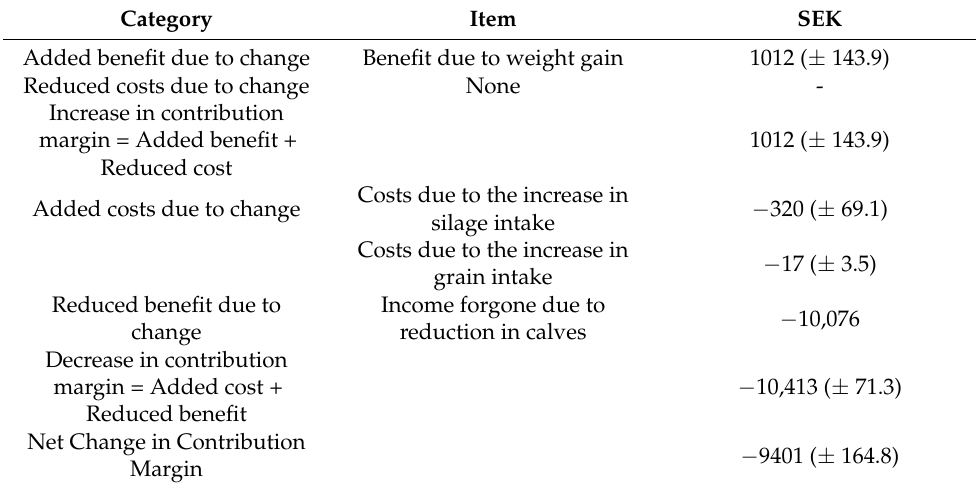
Table 3. Effects a of an increase in space allowance (from 2.2 to 2.7 m 2 /calf)—Scenario